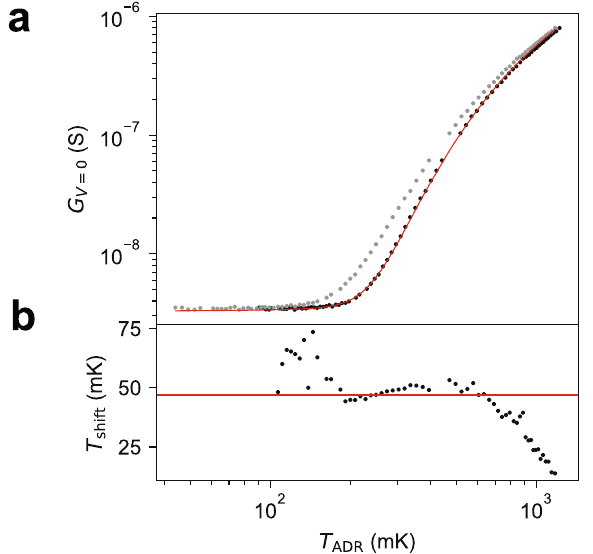
Fig. 10 Dependence of the zero-bias conductance G V = 0 of the normal- metal superconductor tunneling junction on the cryostat temperature T ADR . a Thermal dependence of the zero-bias conductance from the experiment (gray dots) and simulated (red line). The black dots are the same data but shifted rigidly by 45 mK to higher temperatures. b A temperature-dependent shift necessary for matching the experimental and simulated values of G V = 0 shown in a . Red horizontal line marks the value T = 45 shift